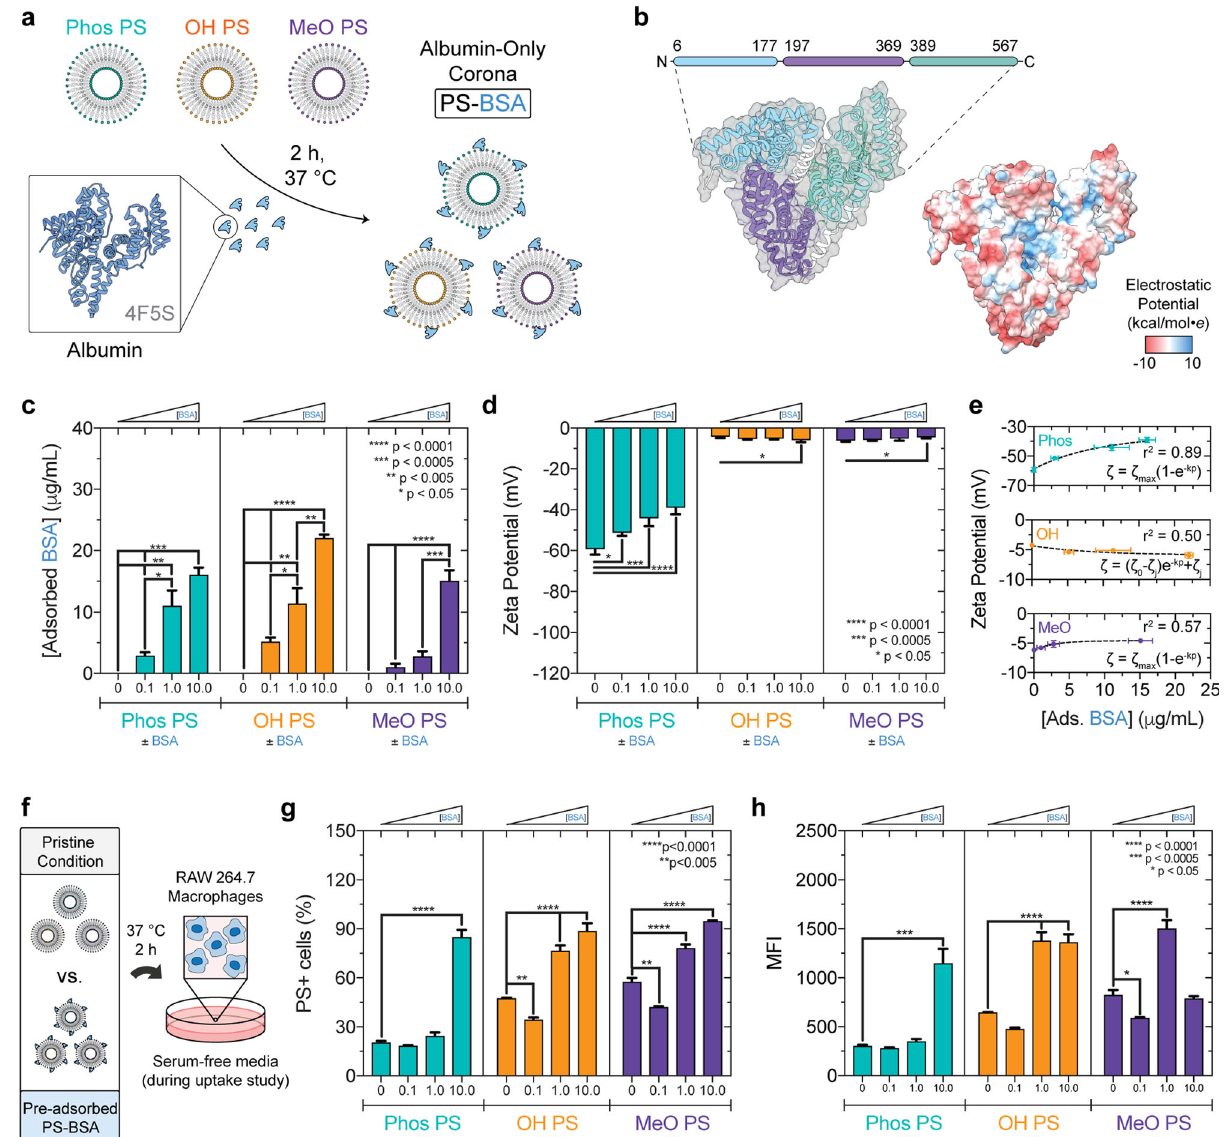
Fig. 3 Adsorbed albumin increases macrophage uptake of all three PS surface chemistries but only signi fi cantly changes the zeta potential for Phos PS. a PS – BSA complexes formed after polymersome (PS) incubation with bovine serum albumin (BSA; 0.1, 1.0, or 10.0 mg/mL). b Pfam domain annotations and Columbic electrostatic surface mapped to the BSA crystal structure (PDB: 4F5S). c Albumin adsorption concentration dependence (2.5 mg/mL PS; x -axis: input BSA concentration). Signi fi cance was determined by ANOVA with post hoc Tukey. d Zeta potential (mV) of PS and PS – BSA complexes. The mean ± s.d. is displayed from three parallel experiments ( n = 3). e PS zeta potential as a function of adsorbed albumin. Non-linear fi ts (dashed lines) for one-phase association (Phos, MeO) and exponential decay (OH) models. f – h Flow cytometric analysis of PS – BSA uptake by RAW 264.7 macrophages in serum-free media (2 h, 37 °C). PS encapsulated Dex 70kDa -TMR to quantify vesicle uptake. f Illustration. g %PS + cells (1.1% false positive rate). h Median fl uorescence intensity (MFI). Error bars represent s.e.m. from three biological replicates ( n = 3) unless indicated otherwise. Signi fi cant differences (PS versus PS – BSA) were determined by ANOVA with post hoc Dunnett ’ s test. Statistical tests used a 5% signi fi cance level. * p < 0.05, ** p